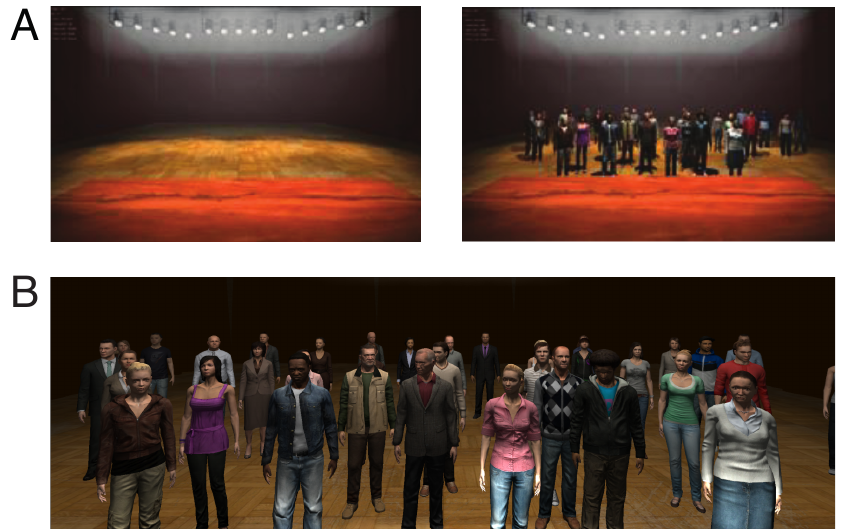
Figure A1. Interactive Virtual Environment: ( A ) Example views of both social conditions (left, empty; right, audience); ( B ) details of a disengaged audience (deadpan: DP, projected: PROJ, and exaggerated: EXAG).